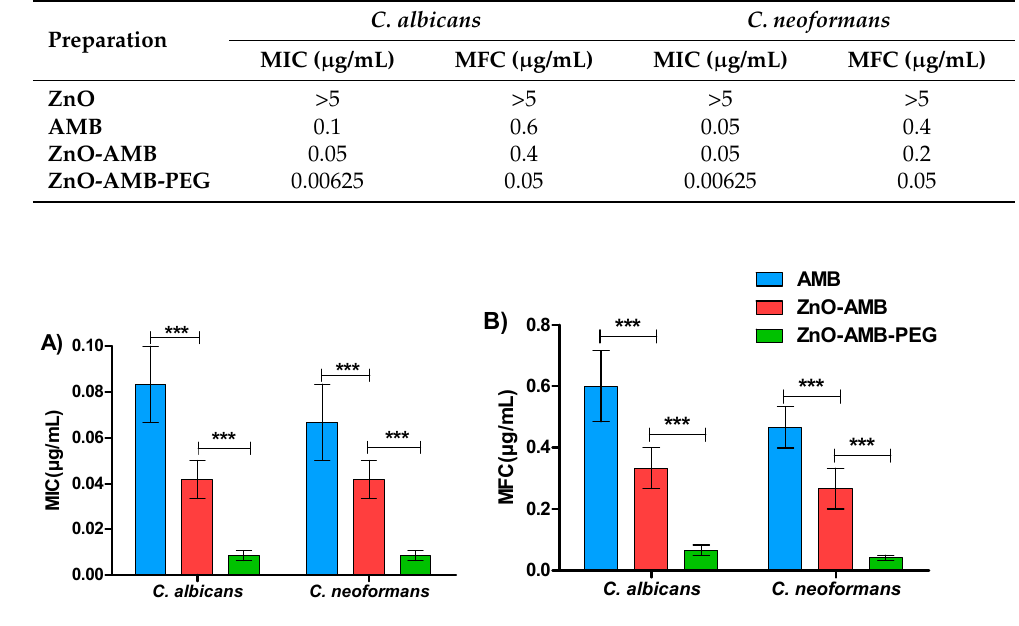
Figure 5. Antifungal susceptibility of ZnO-AMB-PEG compared to ZnO-AMB and free AMB. ( A ) Minimum inhibitory concentration (MIC), and ( B ) minimum fungicidal concentration (MFC) of tested preparations against C. albicans and C. neoformans . Mann–Whitney U analysis demonstrates a statistically significant difference (*** p < 0.001) between C. albicans and C. neoformans in their susceptibilities (MICs and MFCs) to ZnO-AMB-PEG, ZnO-AMB and free AMB.